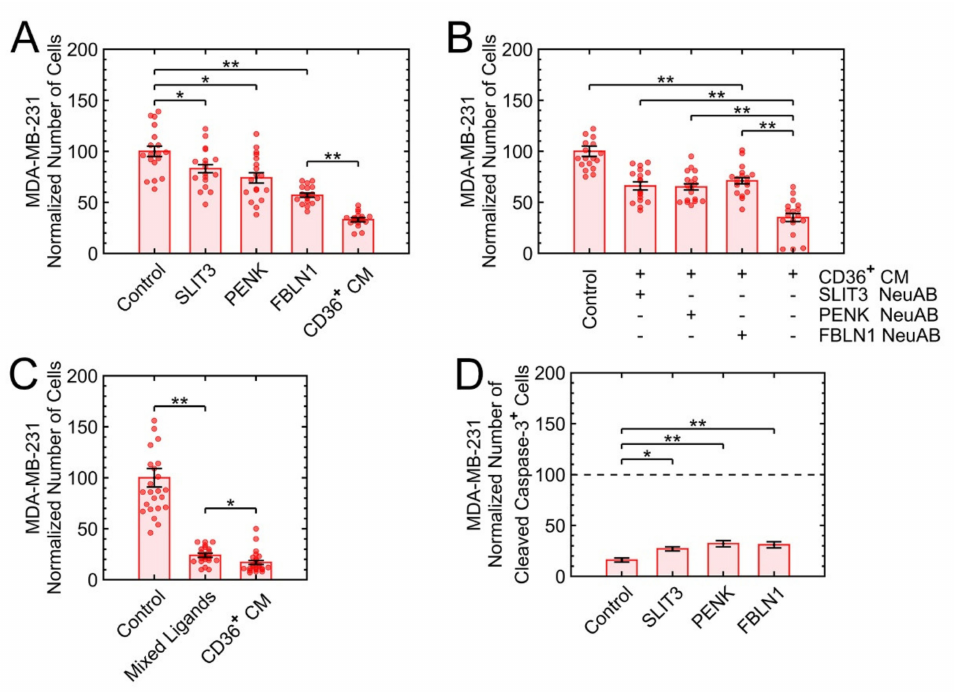
Figure 8. The mixture of three ligands added to the normal culture induces a similar level of growth suppression as the CM of CD36 + FBs. ( A ) The addition of each recombinant protein to the MDA-MB- 231 medium induced partial growth suppression. ( B ) The addition of each neutralizing antibody to the CM of CD36 + FBs interfered partially with the growth suppression. ( C ) Mixed recombinant proteins of SLIT3, PENK, and FBLN1 induced an additive growth suppression that was similar to the CM of CD36 + FBs. ( D ) Protein ligands induced apoptosis via the caspase-3 pathway after one day of treatment. * p < 0.05, ** p <